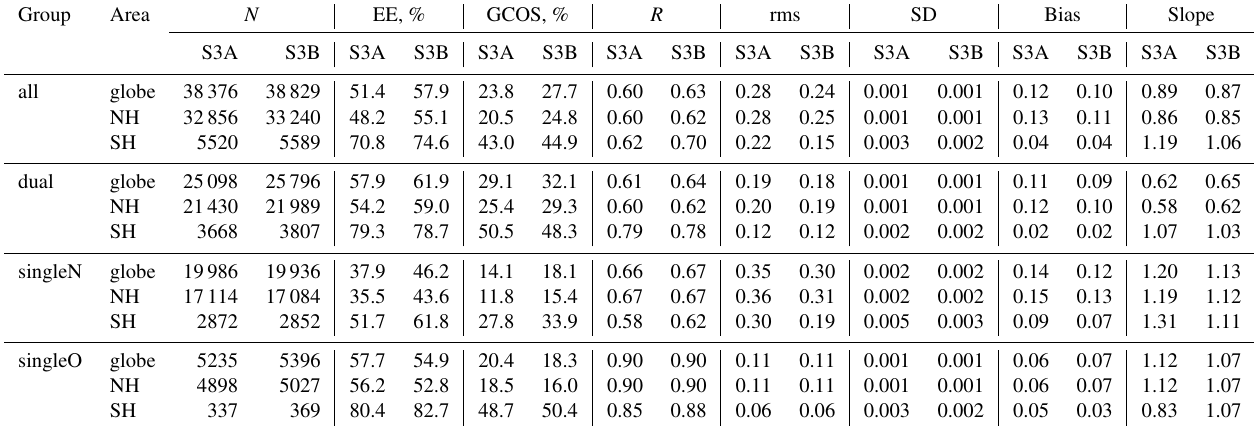
Table 1. Validation statistics (number of points, N ; percentage of matchups which fit into MODIS AOD error envelope, EE, defined as ± 0.05 ± 0.2 × AOD; percentage of matchups which satisfy GCOS requirements of 0.03 or 10% of AOD; correlation coefficient, R ; root mean square, rms; standard deviation, σ ; bias and slope defined with linear regression applied to all available matchups) for S3A and S3B syAOD 550 products for the globe, NH, and SH for the whole period for all matchups and for three groups of matchups, defined with the processor applied (dual, singleN,